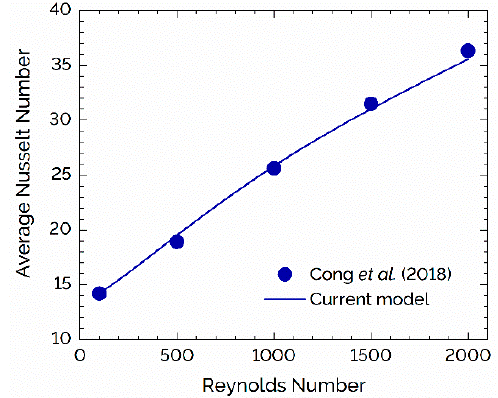
Figure 4. Results from simulations using the current model overlaid onto benchmark results from Cong et al. [6].